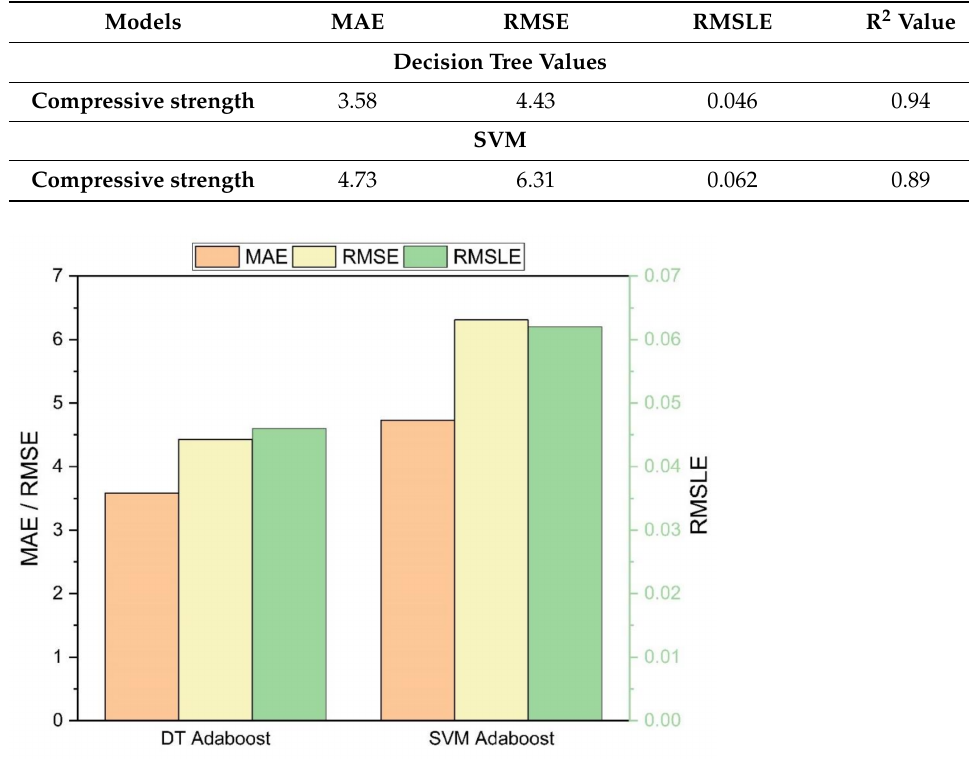
Figure 8. SVM model results for compressive strength; ( a ) individual regression model, ( b ) error distribution between actual and target values of individual model, ( c ) ensemble regression model, and ( d ) error distribution between actual and target values of an ensemble model. Table 6. Statistical errors for the models.